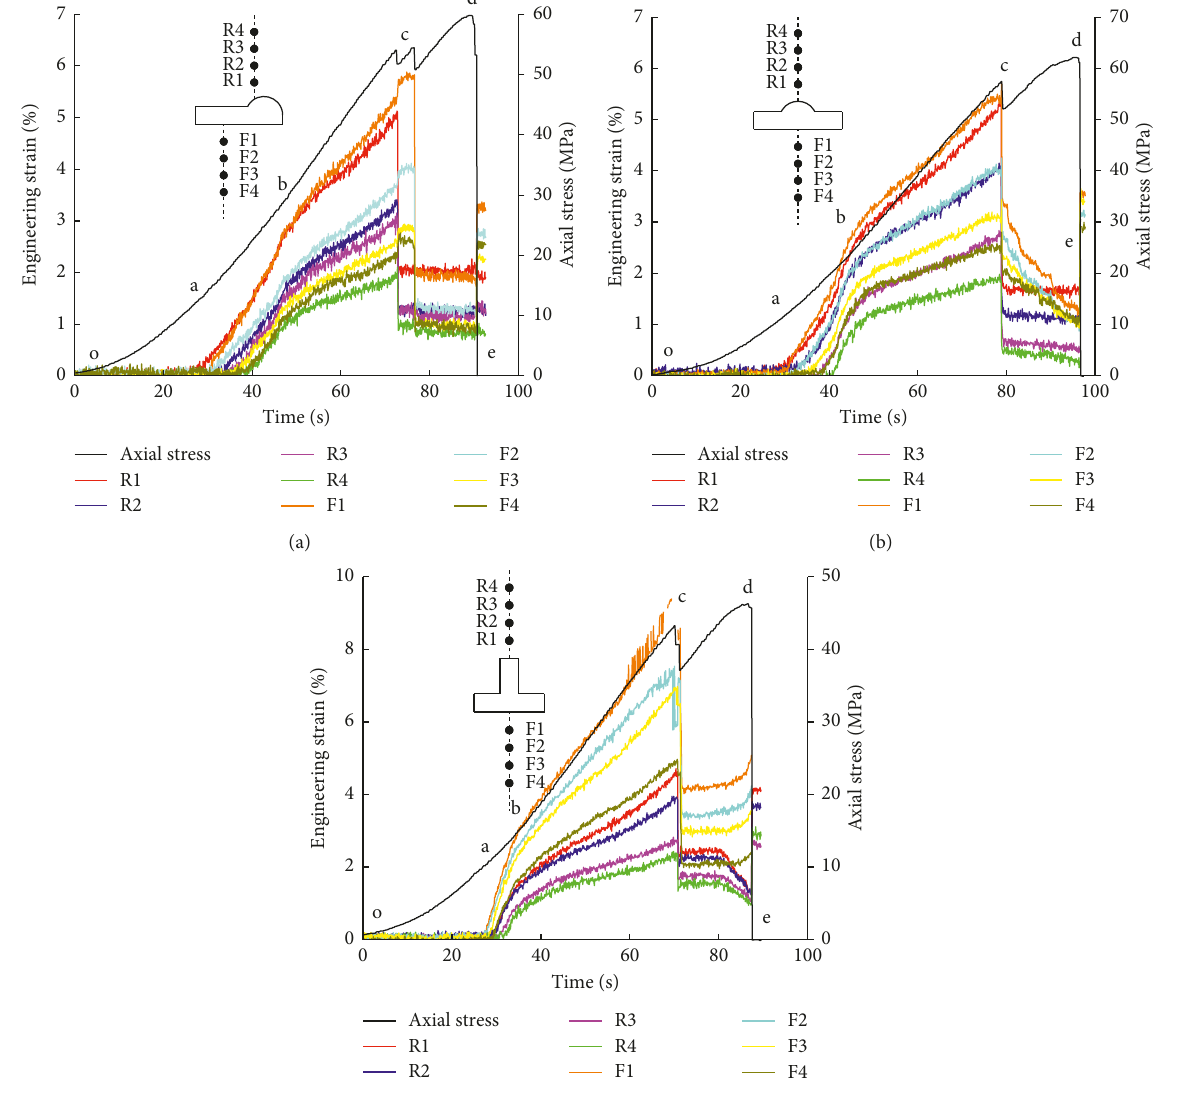
Figure 11: Strain and stress-time curves of monitoring points under uniaxial loading: (a) specimen TI-1; (b) specimen FI-1; (c) specimen